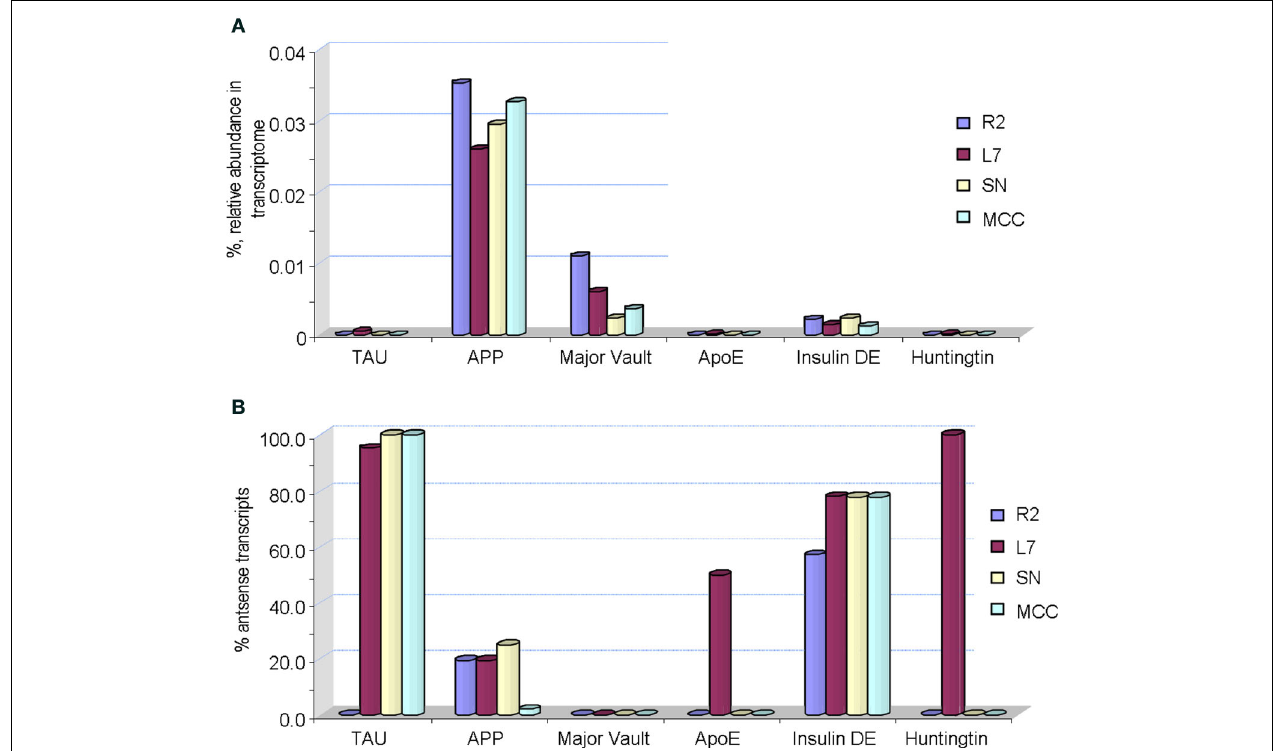
FIGURE 5 | Single cell digital expression profi ling of selected age-related transcripts in Aplysia . (A) Sense transcripts (actual mRNAs) shown as % of their relative abundance in a transcriptome of a given identifi ed neuron (R2 – cholinergic mucus releasing motoneuron; MCC – serotonergic modulatory neurons; SN – glutamergic mechanosensory neurons; L7 – one of the major motoneurons of the siphon-/gill- withdrawal refl ex). (B) Relative abundance of